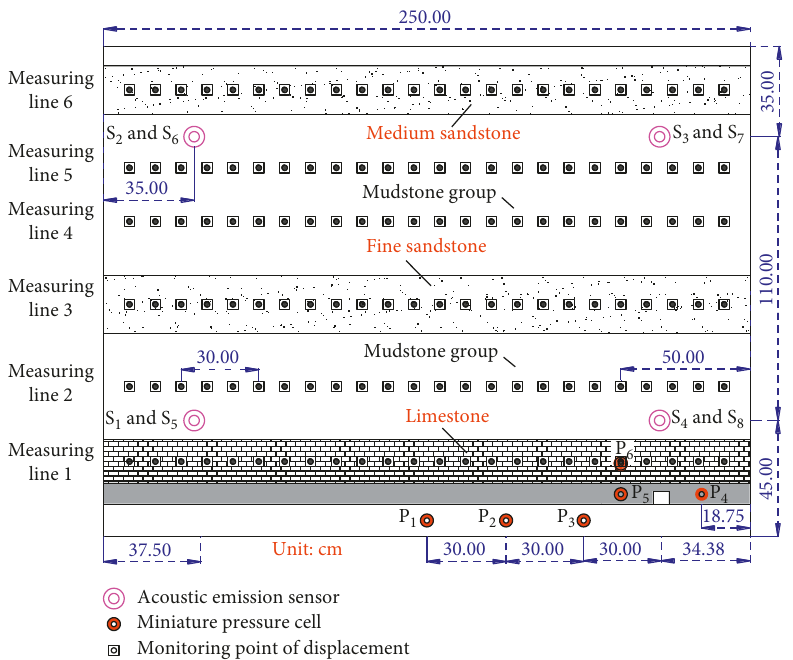
Figure 4: Monitoring programme in the physical